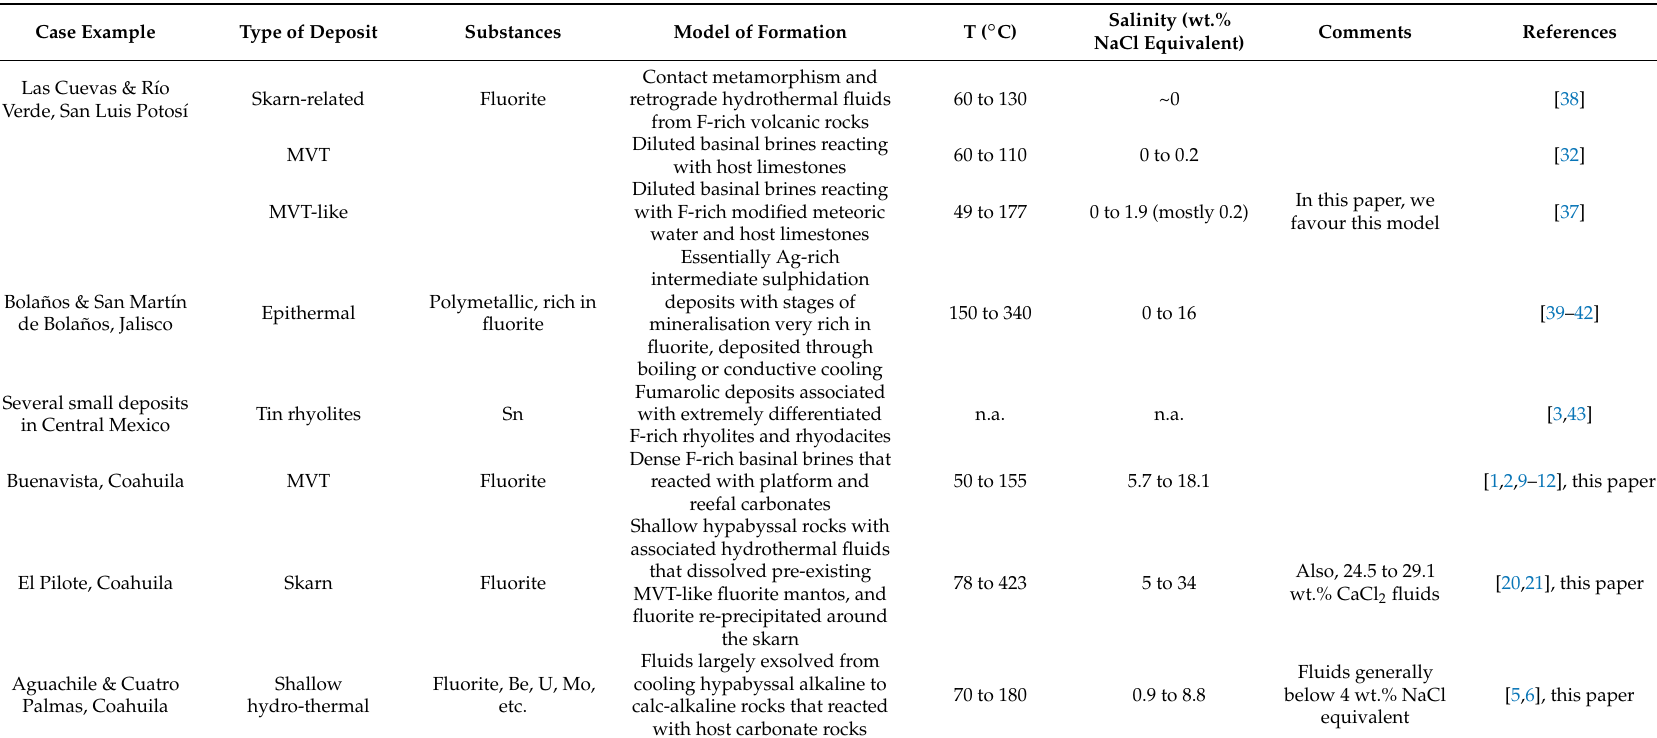
Table 2. Comparative existing models for the formation of fluorite or fluorite-rich hydrothermal deposits in